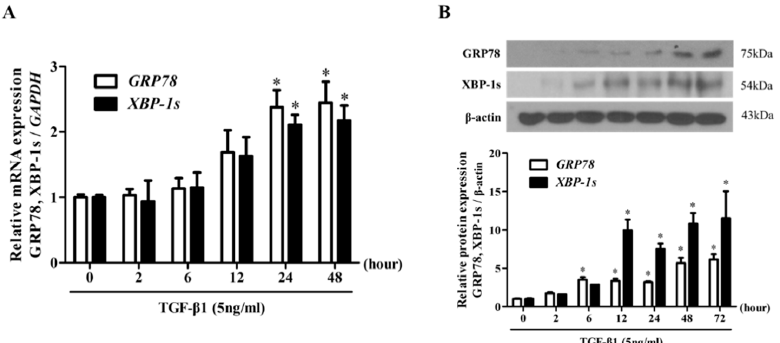
Figure 1. TGF- β 1 upregulates the expression of ER stress-related markers in nasal fibroblasts. ( A ) Nasal fibroblasts were stimulated with TGF- β 1 (5 ng / mL) for 0–48 h. The mRNA levels of ER stress-related markers, GRP78, XBP-1s, were measured by Real-time PCR. Data were normalized to glyceraldehyde 3-phosphate dehydrogenase (GAPDH) expression. ( B ) Fibroblasts were treated with TGF- β 1 (5 ng / mL) for 0–72 h and the protein level of GRP78, XBP-1s was determined using Western blotting. Data were normalized to β -actin expression. Data are presented as mean ± SEM and are representative of at least three independent experiments. * p < 0.05 vs. control.